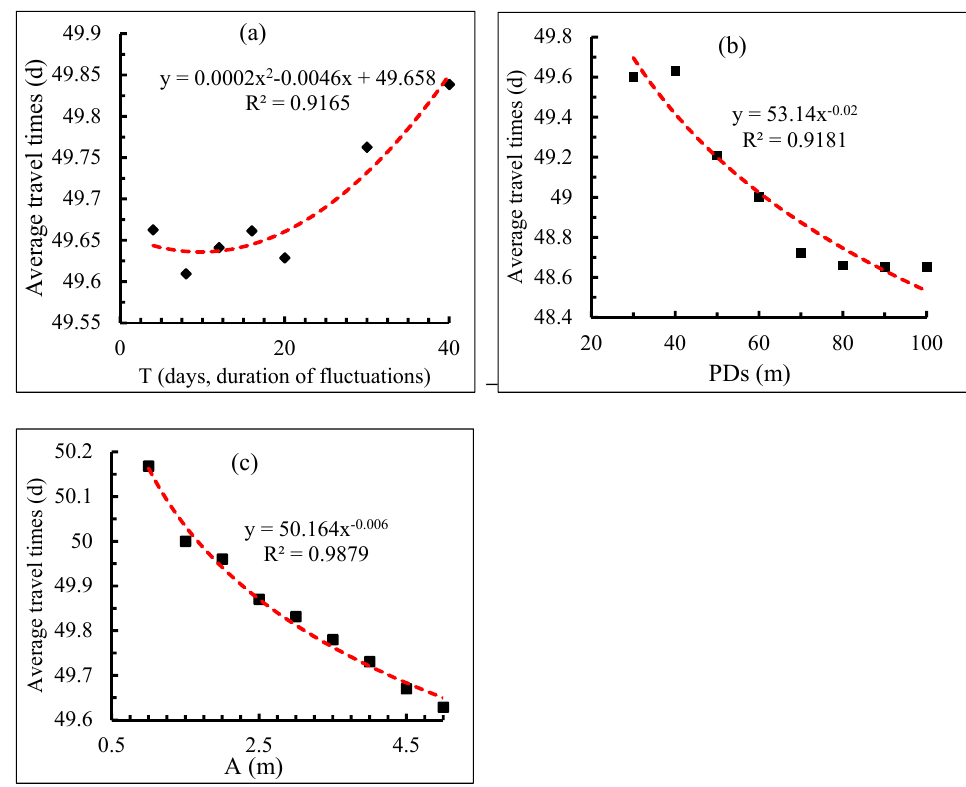
Figure 7. Simulated average travel times for artificially recharged water through a near-bank aquifer. ( a ) is the variation of TT with the change of duration of fluctuation. ( b ) is the variation of TT with the change of penetration depth of SW. ( c ) the variations of TT with the change of the fluctuation